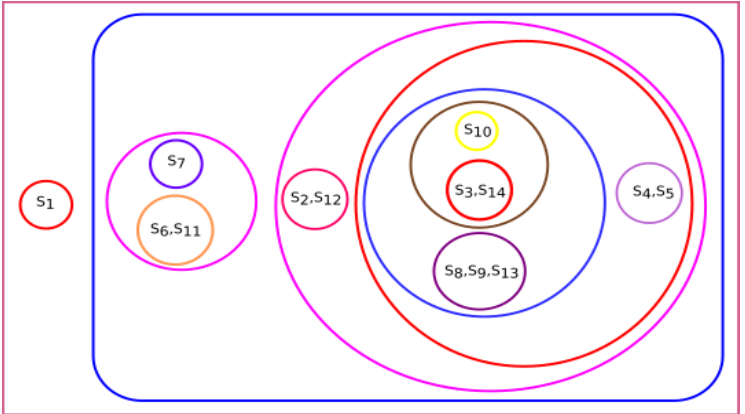
Figure 15. Clusters drawn from hierarchical clustering phylogenetic tree based on fractal dimension. Here, S i indicates the species name as specified in Table